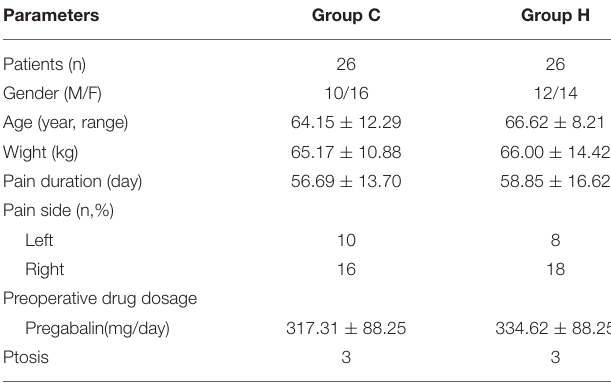
TABLE 1 | The general conditions of the patients (mean ± SD).